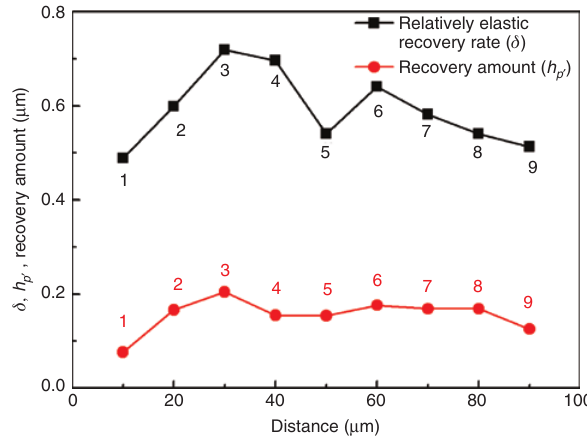
Figure 12: Results of relatively elastic recovery rate δ and recovery amount h . p ′